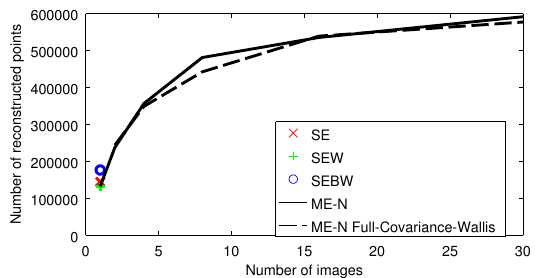
Figure 9. Wall dataset. Number of points of the dense reconstruc- tion for different numbers of images per